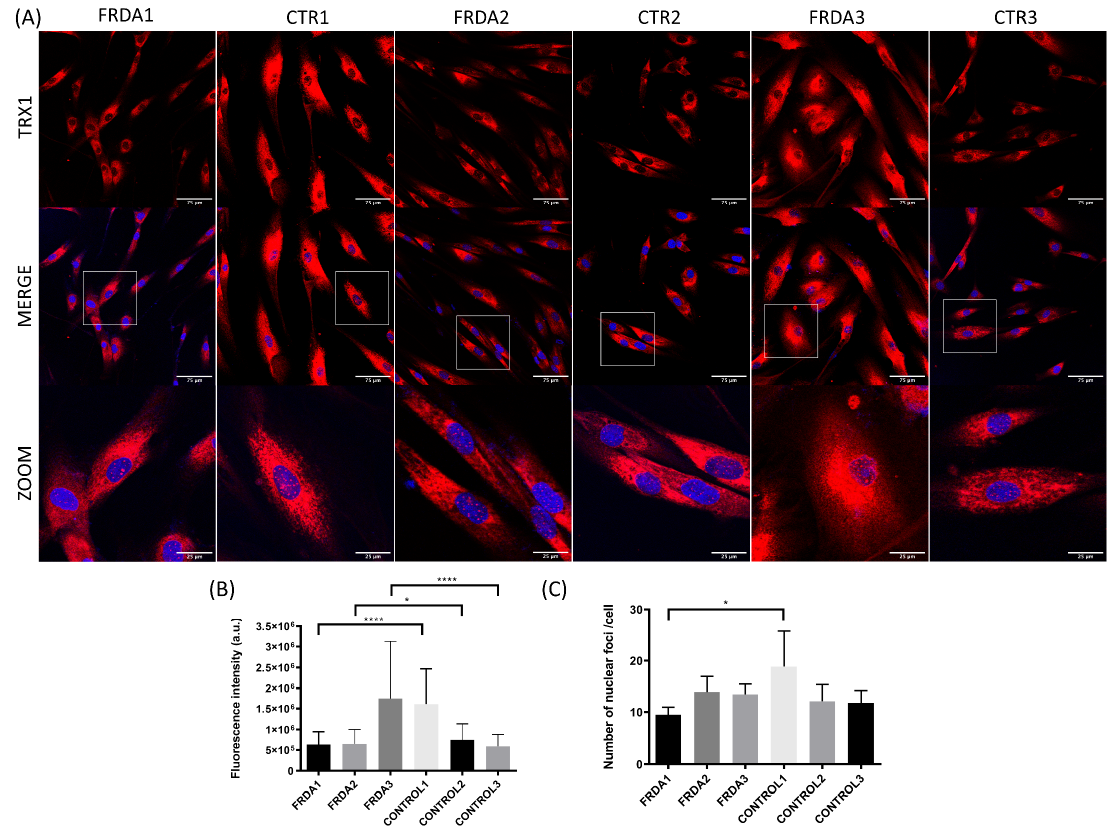
Figure 3. Subcellular localization of TRX1 in fibroblasts from FRDA patients (FRDA1, FRDA2, and n = 3) and from matched healthy subjects (CTR1, CTR2, and CTR3; n = 3). ( A ) Representative images of fibroblasts stained with anti-TRX1 antibody from each patient and healthy subject. Confocal images show the maximal intensity projection. The images were used to determine the subcellular localization of TRX1 (red). The nuclei were stained with Hoechst (blue), and zooms show the colocalization nuclear region. ( B ) Quantification of relative fluorescence intensity of TRX1 from confocal images in each cell line of fibroblasts from FRDA patients and controls. Fluorescence intensity was measured for each cell in at least three di ff erent images of each cell line using ImageJ software. The Mann–Whitney test was used to compare each patient with its paired control to obtain statistical significance. ( C ) Quantification of the number of nuclear foci of TRX1 per cell. The total number of nuclear foci was measured in cells with the entire nuclei and was normalized by the number of total cells. At least three di ff erent images of each cell line were measured using ImageJ software. The Mann–Whitney test was used to compare each patient with a control to obtain statistical significance. The statistical analyses were performed using Graphpad prism 8.0 software. Statistical significance refers to the values for the matched healthy subject for each FRDA patient (* p < 0.05, **** p < 0.0001). Methodology is described in Supplementary